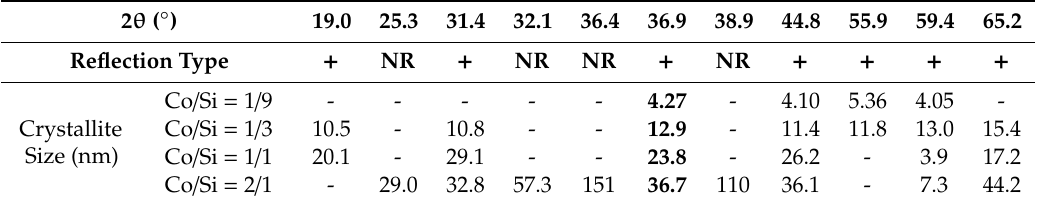
Table 5. Summary of XRD results for Co / Si = X (X = 1 / 9; 1 / 3; 1 / 1; 2 / 1) catalyst with crystallite size at a given di ff raction angle (2 θ ). Microwave radiation power is 900 W. Dominant di ff raction (in bold) is at 2 θ = 36.9 ◦ . ( + ) represents standard reflections of Co 3 O 4 , (NR) represents new reflections.